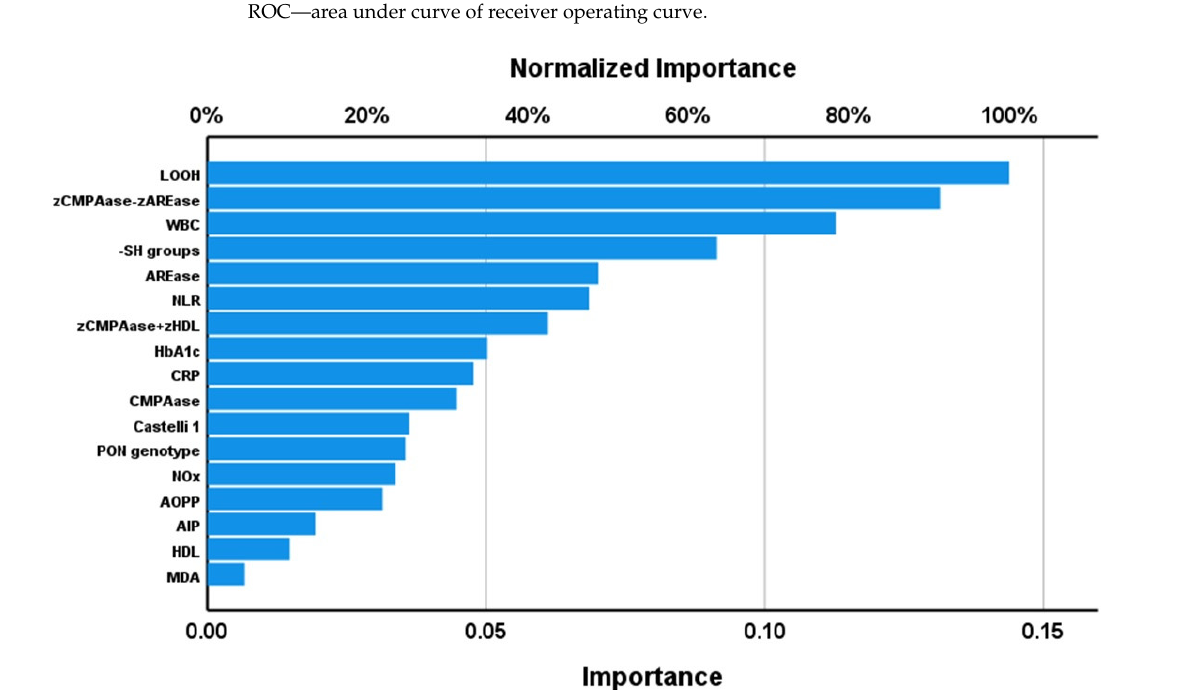
ROC—area under curve of receiver operating curve.